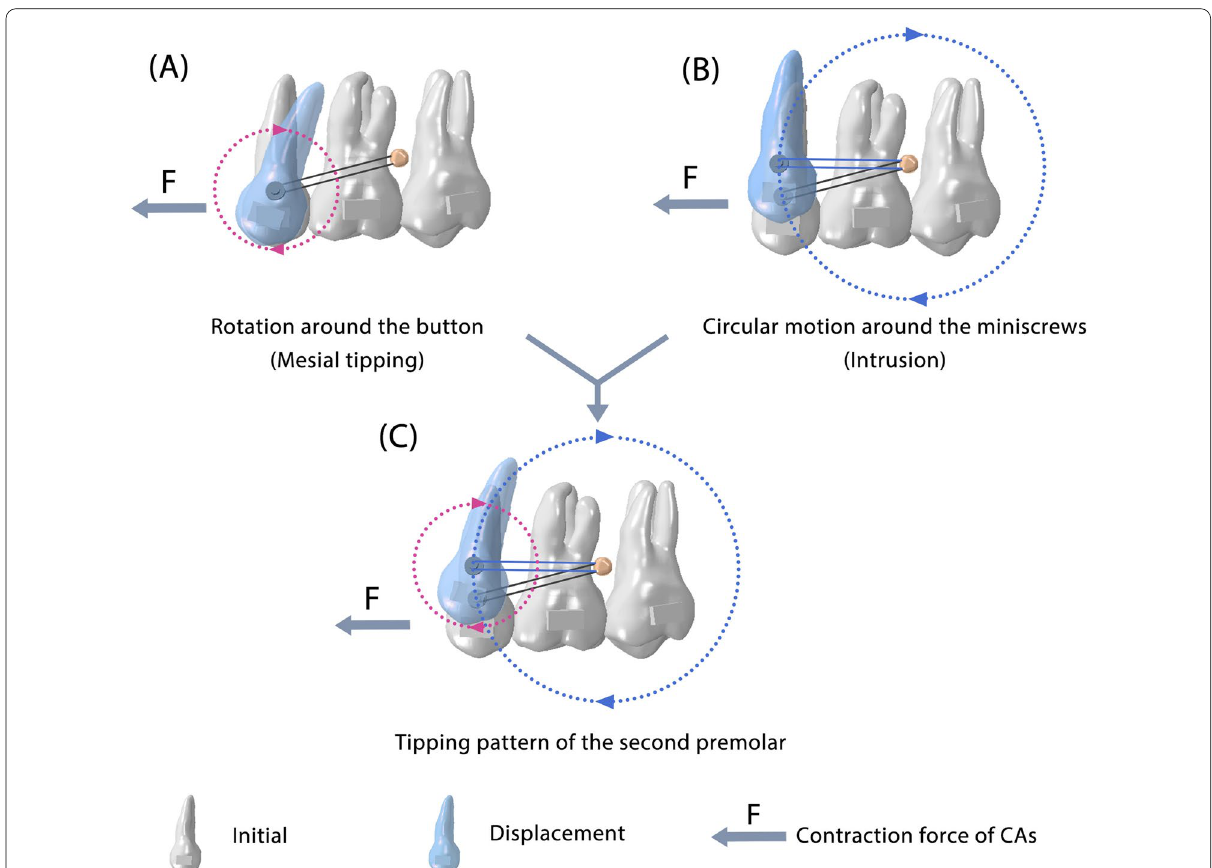
Fig. 6 Tipping movement of the second premolars under indirect strong anchorage control can be decomposed into two circular motions. A Circular motion around the button. B Circular motion around the miniscrew. C ) Schematic diagram of the integral tipping movement of the second